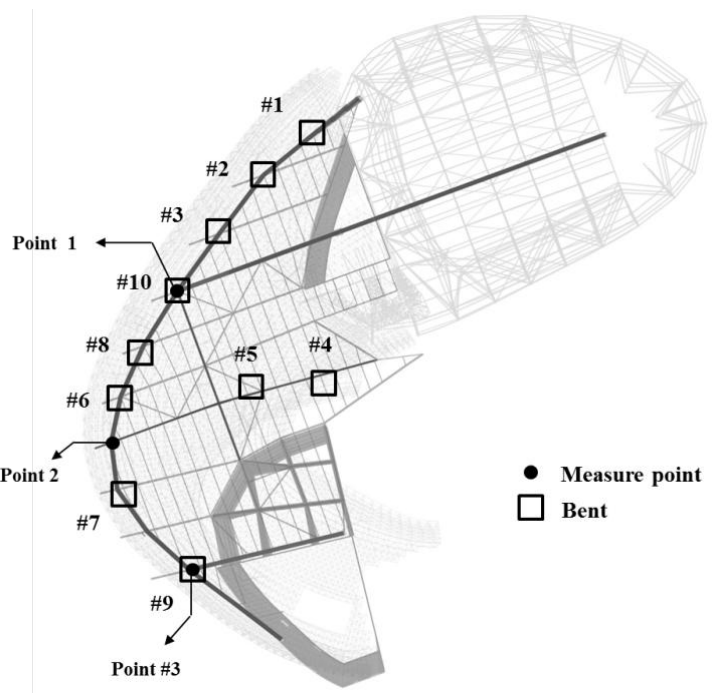
Figure 6. Removal schedule for temporary bents.